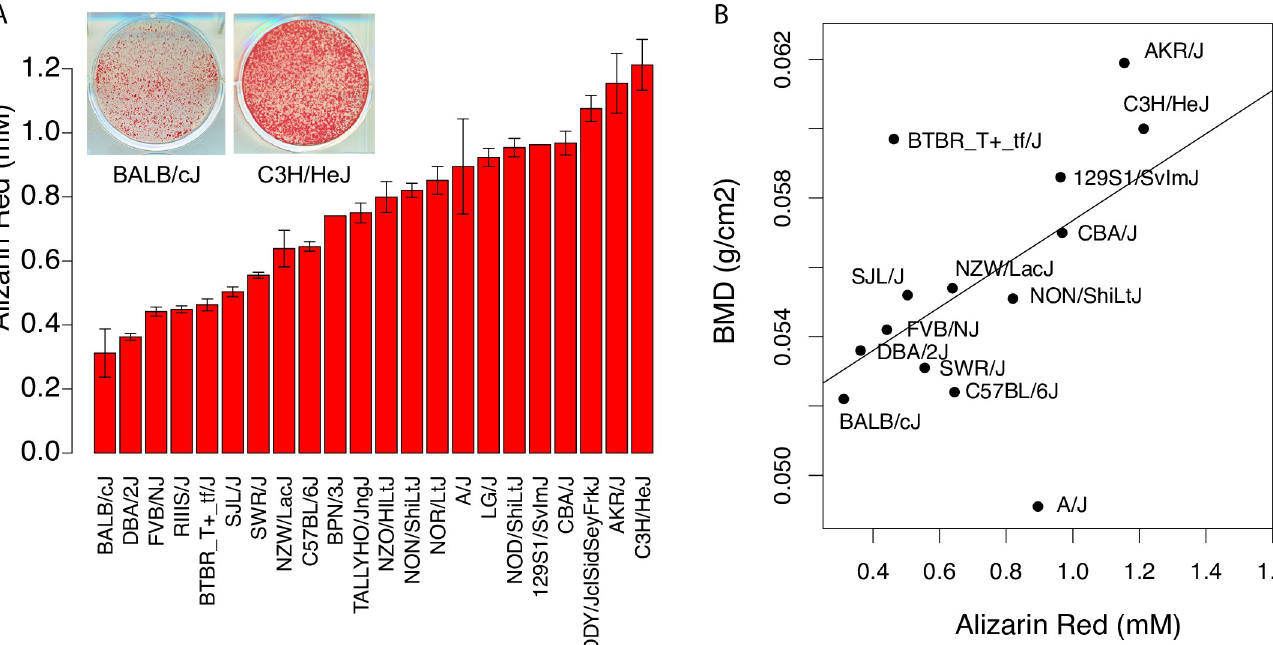
Fig 1. In vitro osteoblast mineralized nodule formation is a heritable trait and correlates with in vivo BMD. (A) Quantification of Alizarin Red-stained cultures of calvarial osteoblasts isolated from 22 inbred mouse strains after 10 days of osteogenic differentiation. Data are presented as mean ± S.E.M. (B) Alizarin Red values correlate significantly with areal BMD in mouse strains ( r = 0.54 p = 0 . 03 ; BMD data from Ackert1 [35],